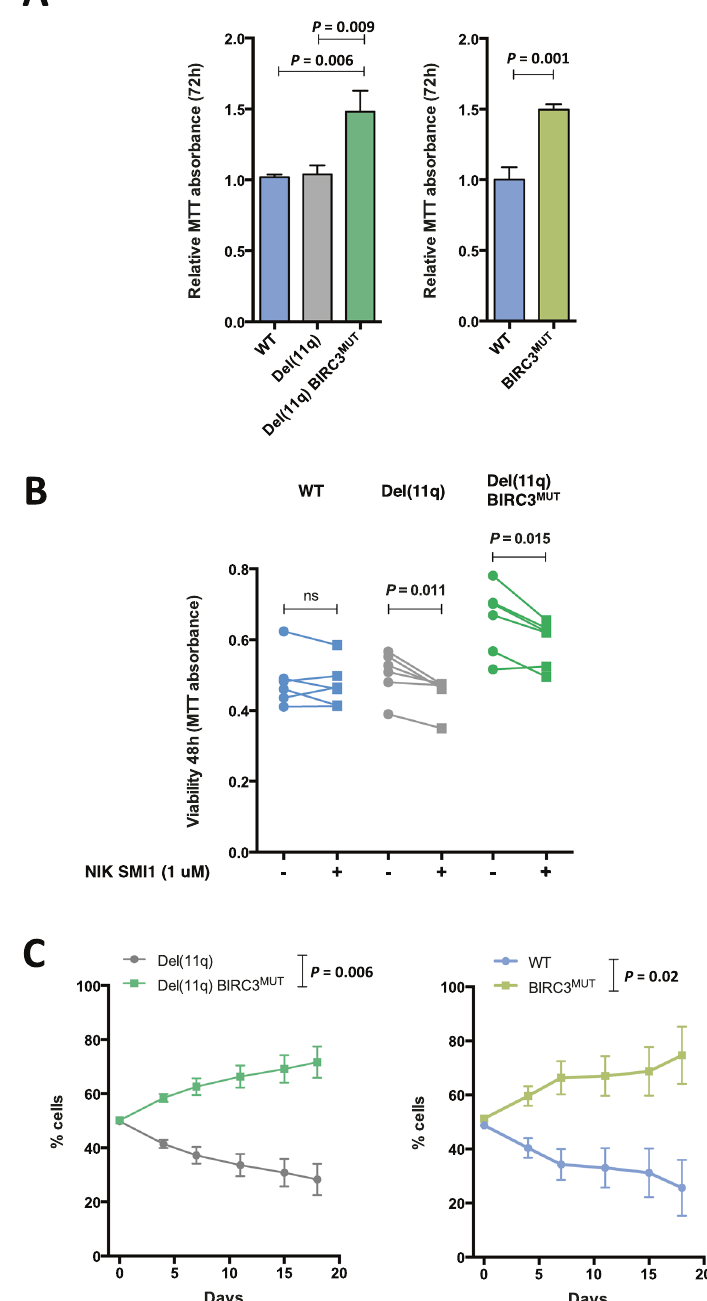
Fig. 5 Effects of del(11q) and/or BIRC3 mutations in CLL cell lines proliferation and clonal evolution. A Analysis of del(11q) and/or BIRC3 mutations on proliferation of HG3 cells after 72 h. MTT absorbance values are normalized with the HG3 WT clones. Data are summarized as the mean ± SD. B Viability analysis of HG3 WT , HG3-del(11q), and HG3-del(11q) BIRC3 MUT cells treated with DMSO or 1 μ M NIK SMI1. Cell viability was assessed by MTT assay after 48 h and data is represented as the absolute absorbance value for each independent clone. C HG3-del(11q) RFP-tagged and HG3-del(11q) BIRC3 MUT GFP-tagged cells (left panel), HG3 WT RFP-tagged and HG3 BIRC3 MUT GFP-tagged cells (right panel), were mixed at a ratio 1:1 and left in culture for the indicated days. Clonal evolution was assessed at the indicated time points by fl ow cytometry. Bars represent mean ±